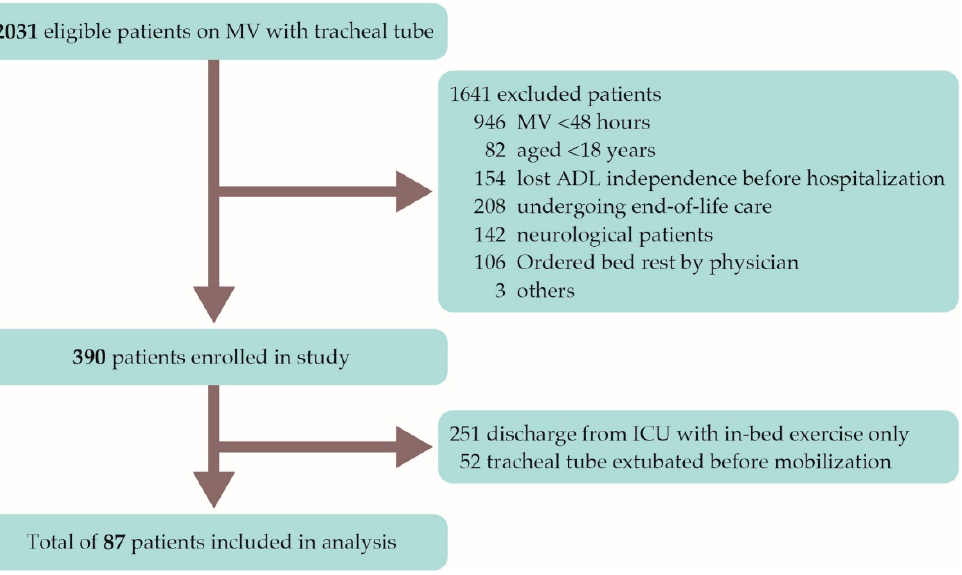
Figure 1. Flowchart of patient recruitment. MV: mechanical ventilation; ADL: activities of daily living; ICU: Intensive Care Unit.